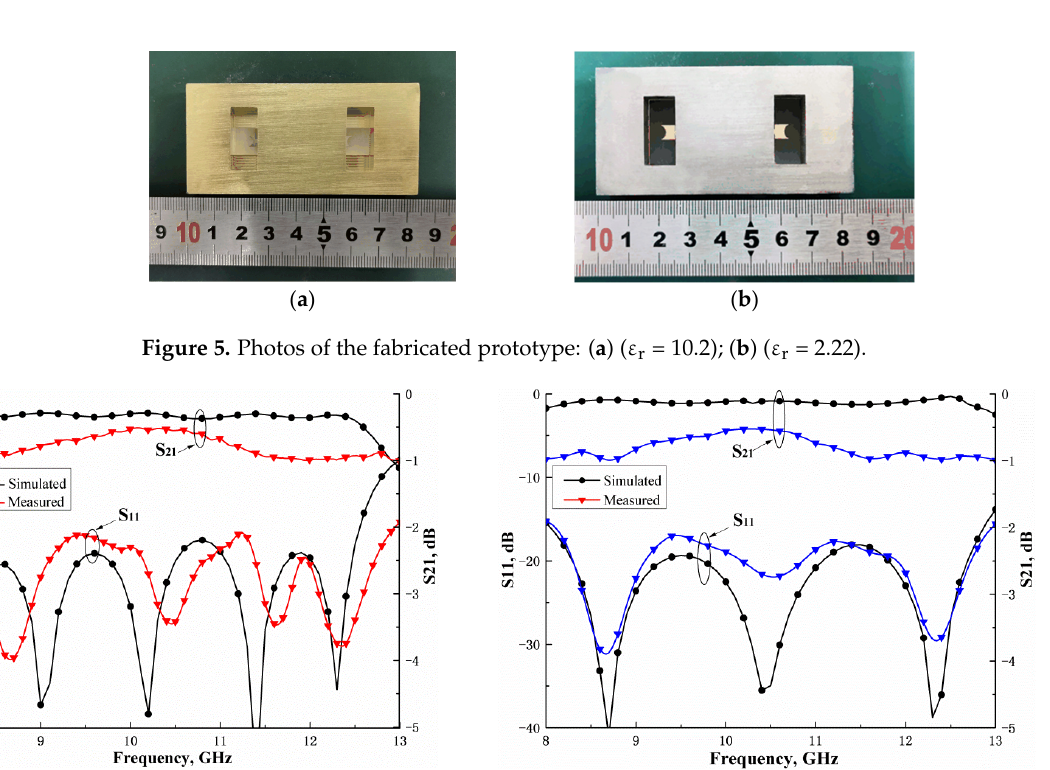
Figure 6. Measured and simulated results for the back-to-back transition: ( a ) ( ε r = 10.2); ( b ) ( ε r = 2.22).